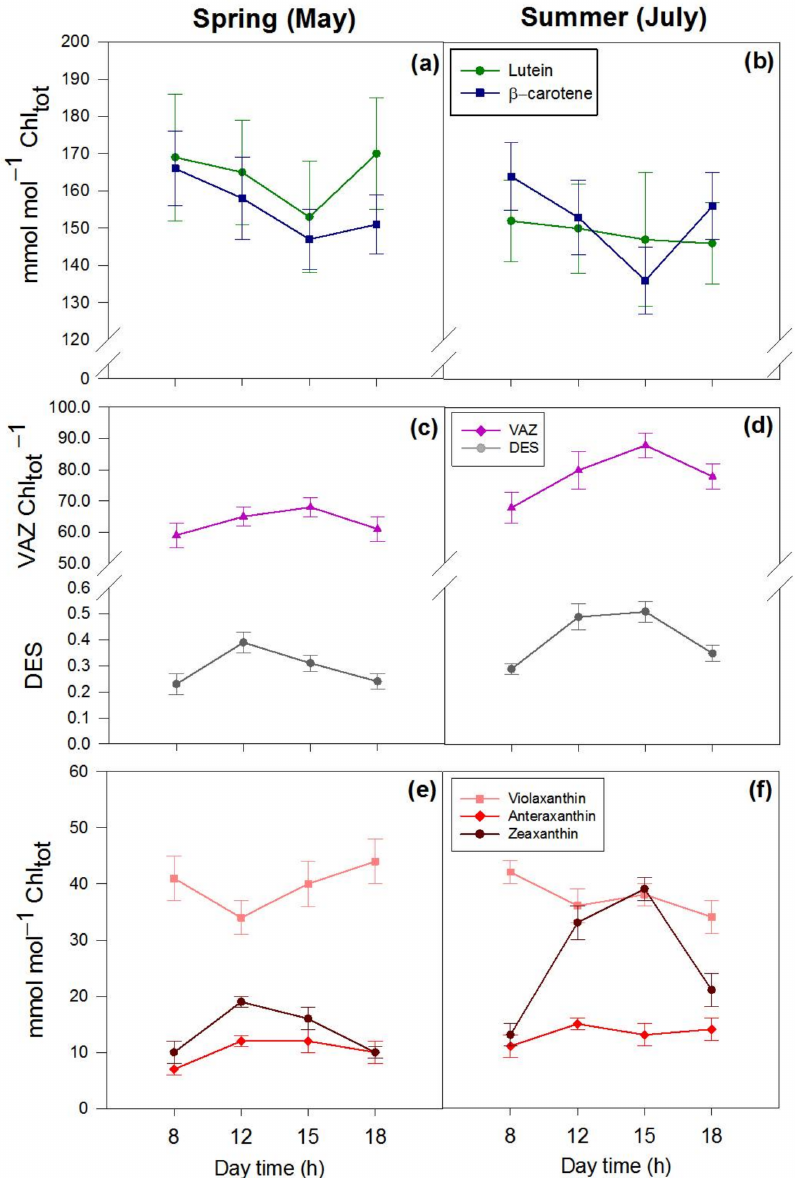
Figure 3. Daily variations in the content of individual carotenoids (mmol mol − 1 Chl tot ) in spring (( a , c , e )—left) and summer (( b , d , f )—right) leaves of P. latifolia . ( a , b ) Content of ß-carotene and lutein; ( c , d ) ratio of violaxanthin cycle pigments (VAZ) relative to total chlorophyll concentration (VAZ Chl tot − 1 ) and the de-epoxidation state of VAZ (DES = ((0.5A + V) (VAZ) − 1). ( e , f ) Content of violaxanthin cycle pigments (violaxanthin, anteraxanthin and zeaxanthin). Leaves were sampled at 08:00–09:00 (8 h in the graphs), 12:00–13:00 (12 h), 14:30–15:30 (15 h) and 17:30–18:30 (18 h)